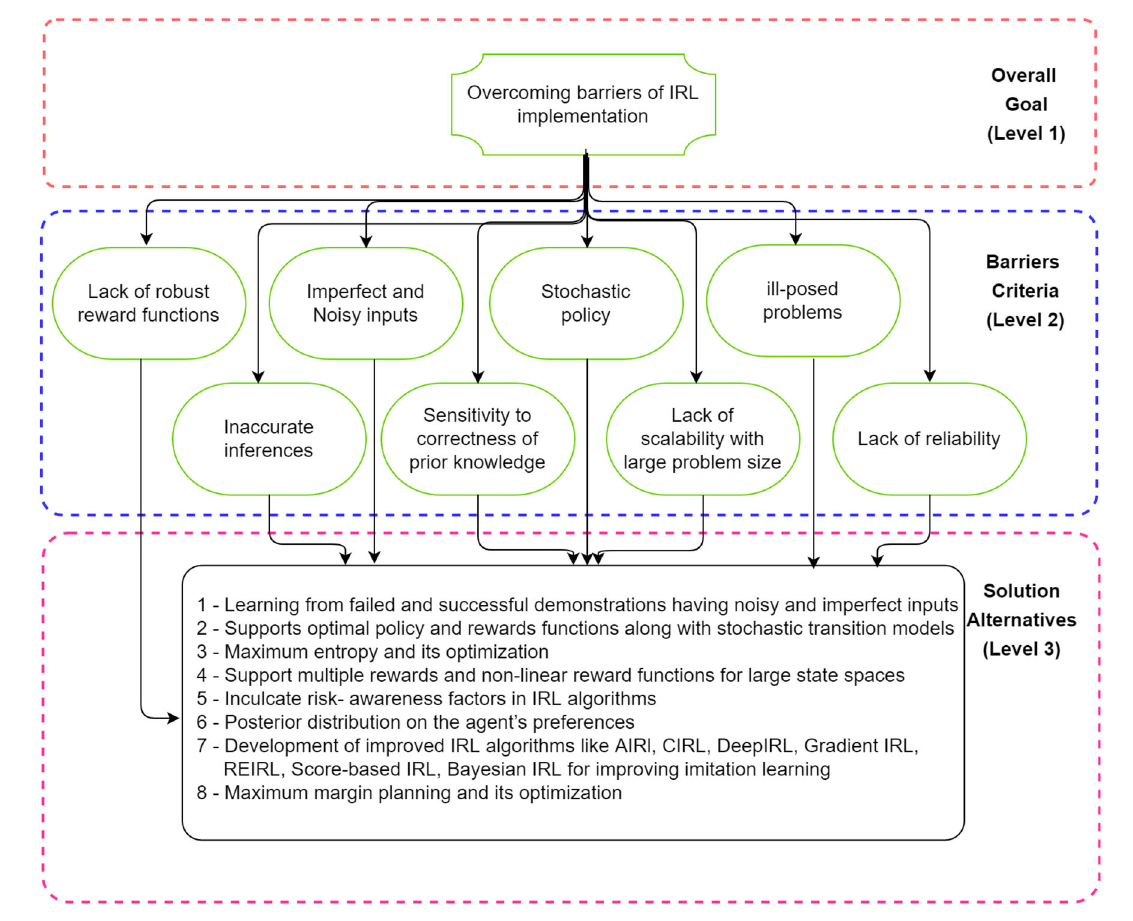
Fig. 2 Decision hierarchy for overcoming barriers to IRL implementation